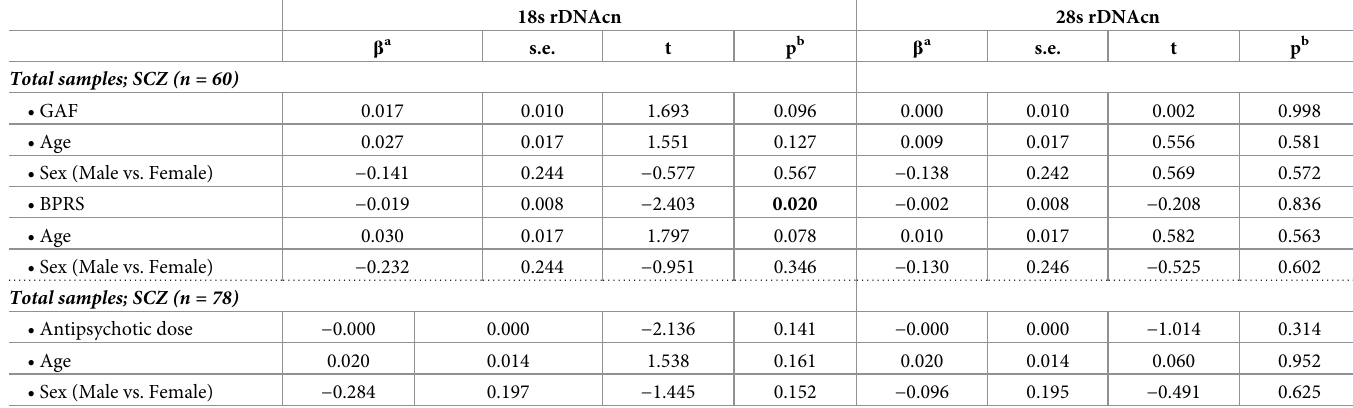
Table 2. Results of regression analysis between rDNAcn of peripheral blood and the clinical demographics in patients with SCZ.